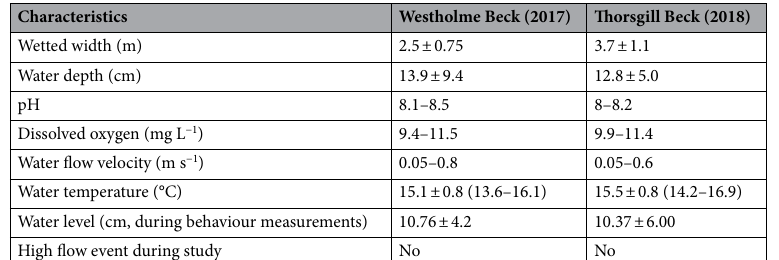
Table 1. Measured habitat/environmental characteristics of the study sites (as Mean ± SD or range). Measurements for width, depth and flow velocity were made during crayfish recapture surveys in September of each year, while measures of pH, water temperature and dissolved oxygen were made from early August to late September. Measurement method details are available in the supplementary methods.